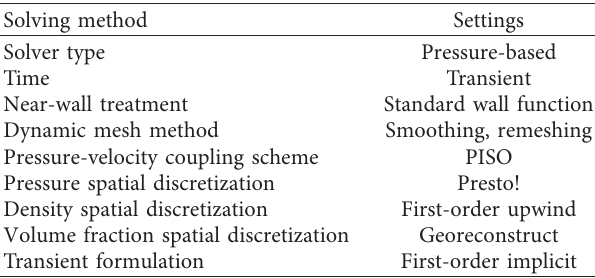
Figure 5: (a) The defined moving boundaries; (b) plot of boundary velocity versus time in compression stroke; (c) plot of boundary velocity versus time in extension stroke. Table 3: Calculation settings for the transient